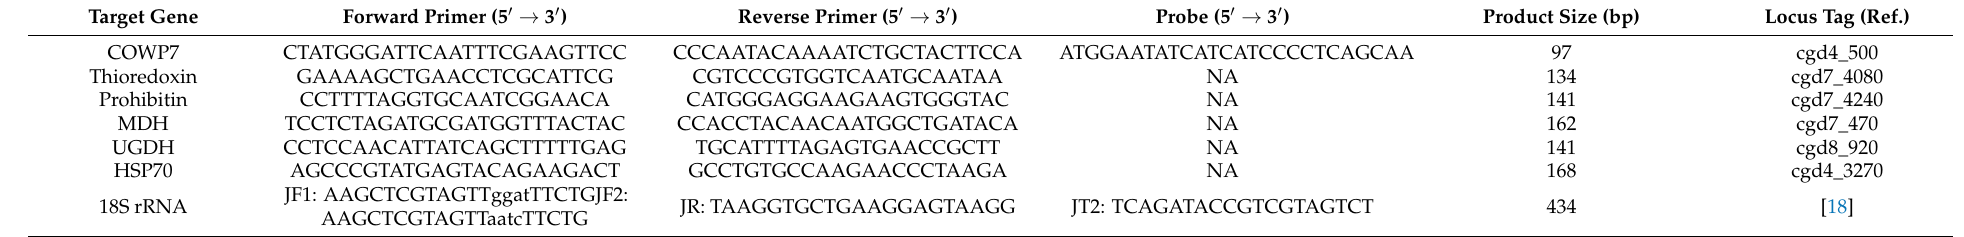
Table 2. Oligos employed to evaluate the validity of selected target genes in the development of new RT-qPCR method to assess the viability of Cryptosporidium oocysts. Target